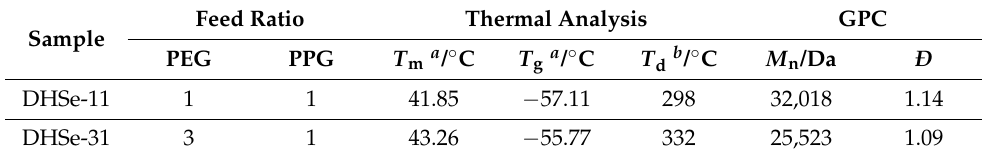
Table 1. Molecular characteristics and thermal properties of poly(DHSe/PEG/PPG urethane).